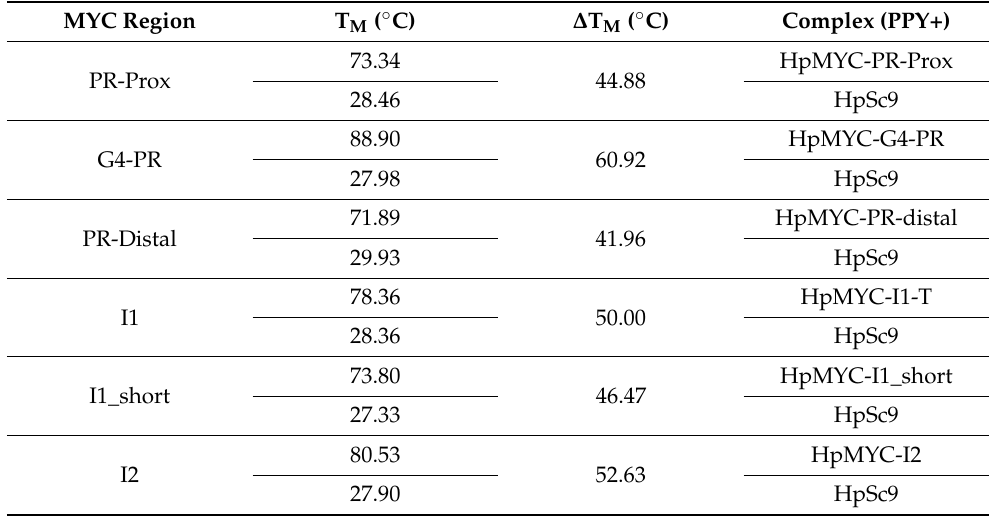
Table 2. Melting temperatures (T Ms ) of the different polypyrimidine single-stranded targets (PPY) with their corresponding PPRH and HpSc9.